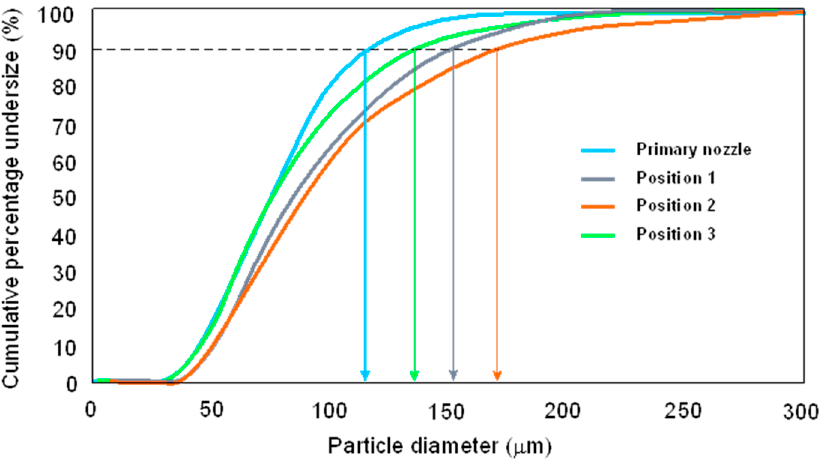
Figure 12. Comparison of particle size distributions of the powder samples collected from the experimental trials for all tested nozzle positions Ref. [9].